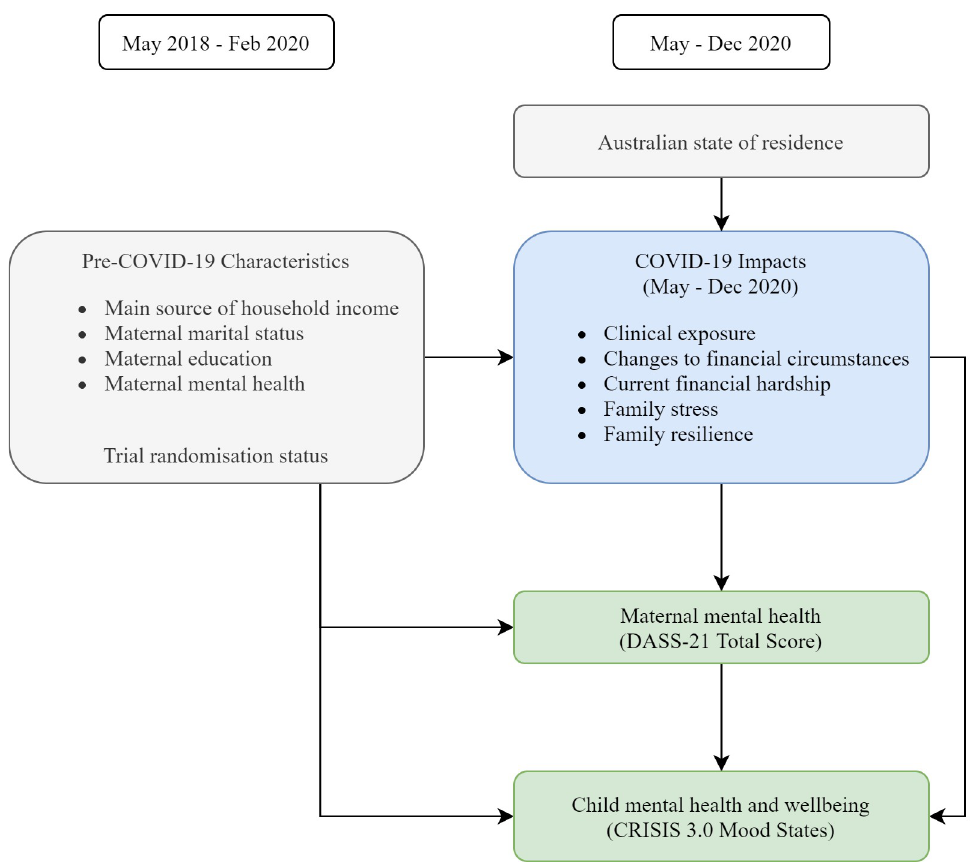
Fig 2. Conceptual model of COVID-19 impacts and their associations with maternal and child mental